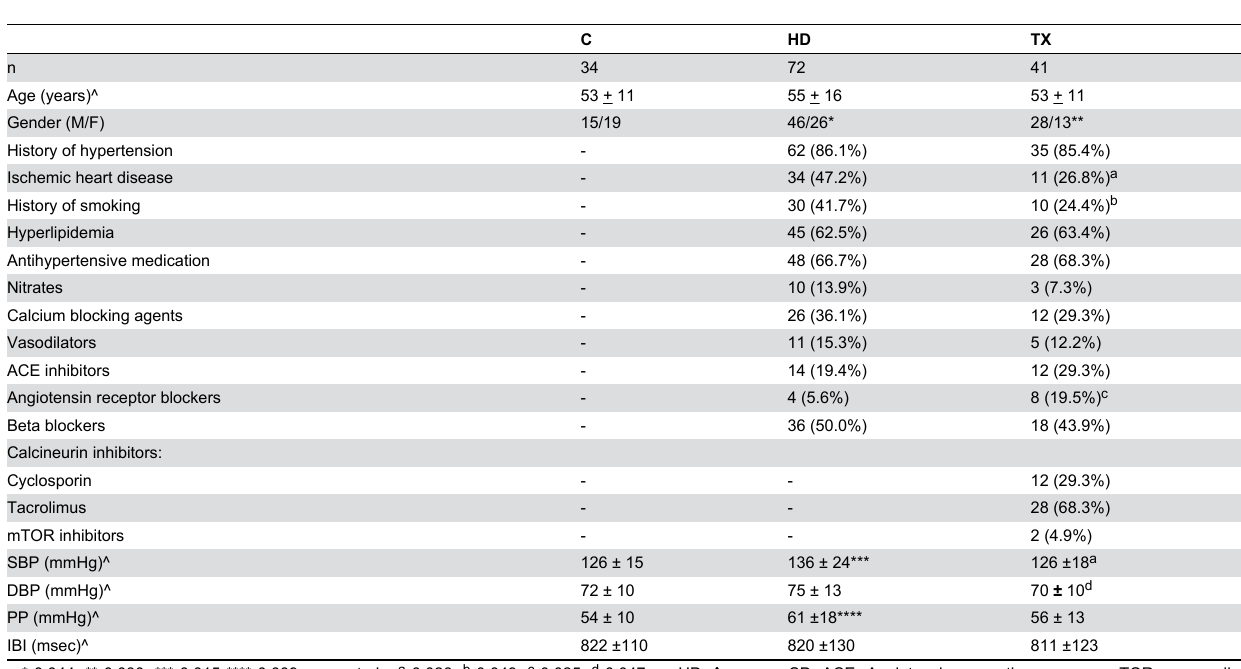
Table 1. Demographic and clinical data of controls (C), of hemodialysis (HD) and transplanted (TX)